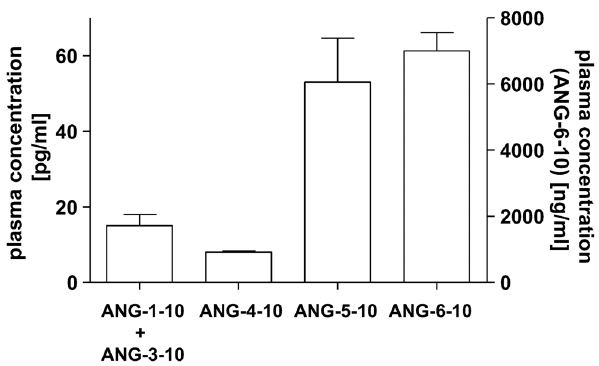
Figure 3. Detection of endogenous angiotensin peptides in human plasma. Concentrations of ANG-1-10 + ANG-3-10, ANG-4-10, ANG-5-10 (shown on left y-axis) and ANG-6-10 (shown on right y-axis) were determined by an immuno-fluorescence